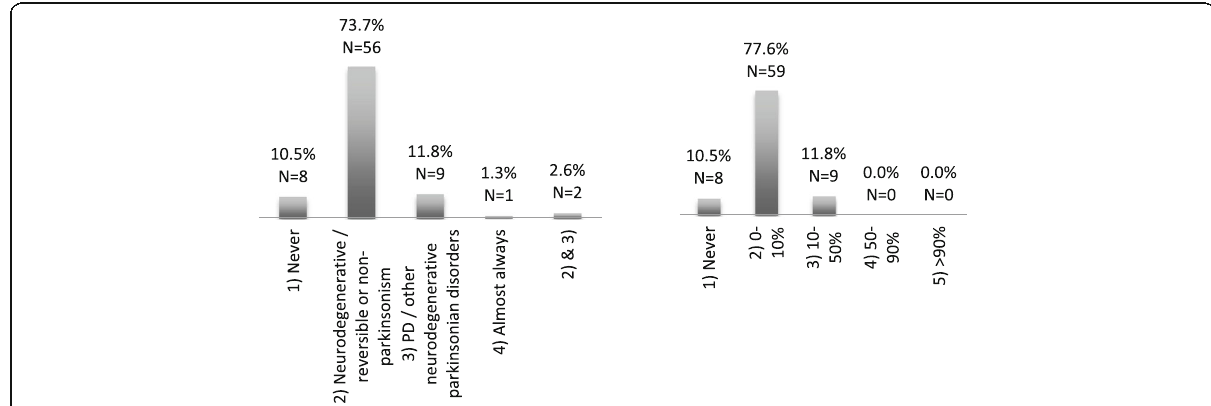
Fig. 2 Results of the “ Request of DAT SPECT imaging ” survey. (1) In which case do you request DAT SPECT imaging? (left panel). (2) How often do you request DAT SPECT imaging? (right panel). DAT, dopamine transporter; SPECT, single-photon emission computed tomography;